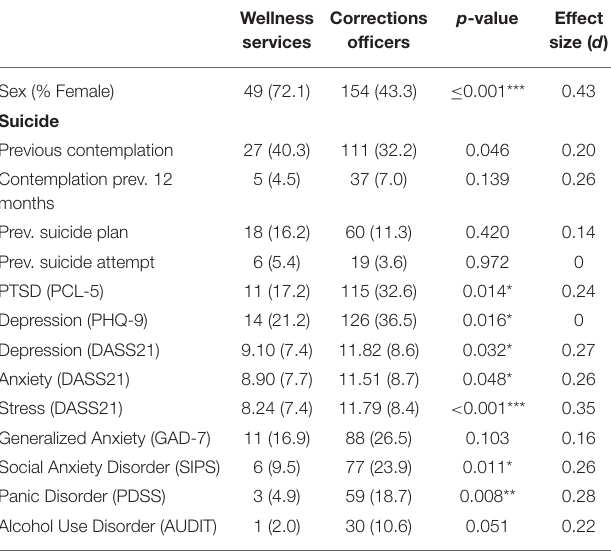
TABLE 3 | Demographic and screening comparisons between institutional wellness services and corrections